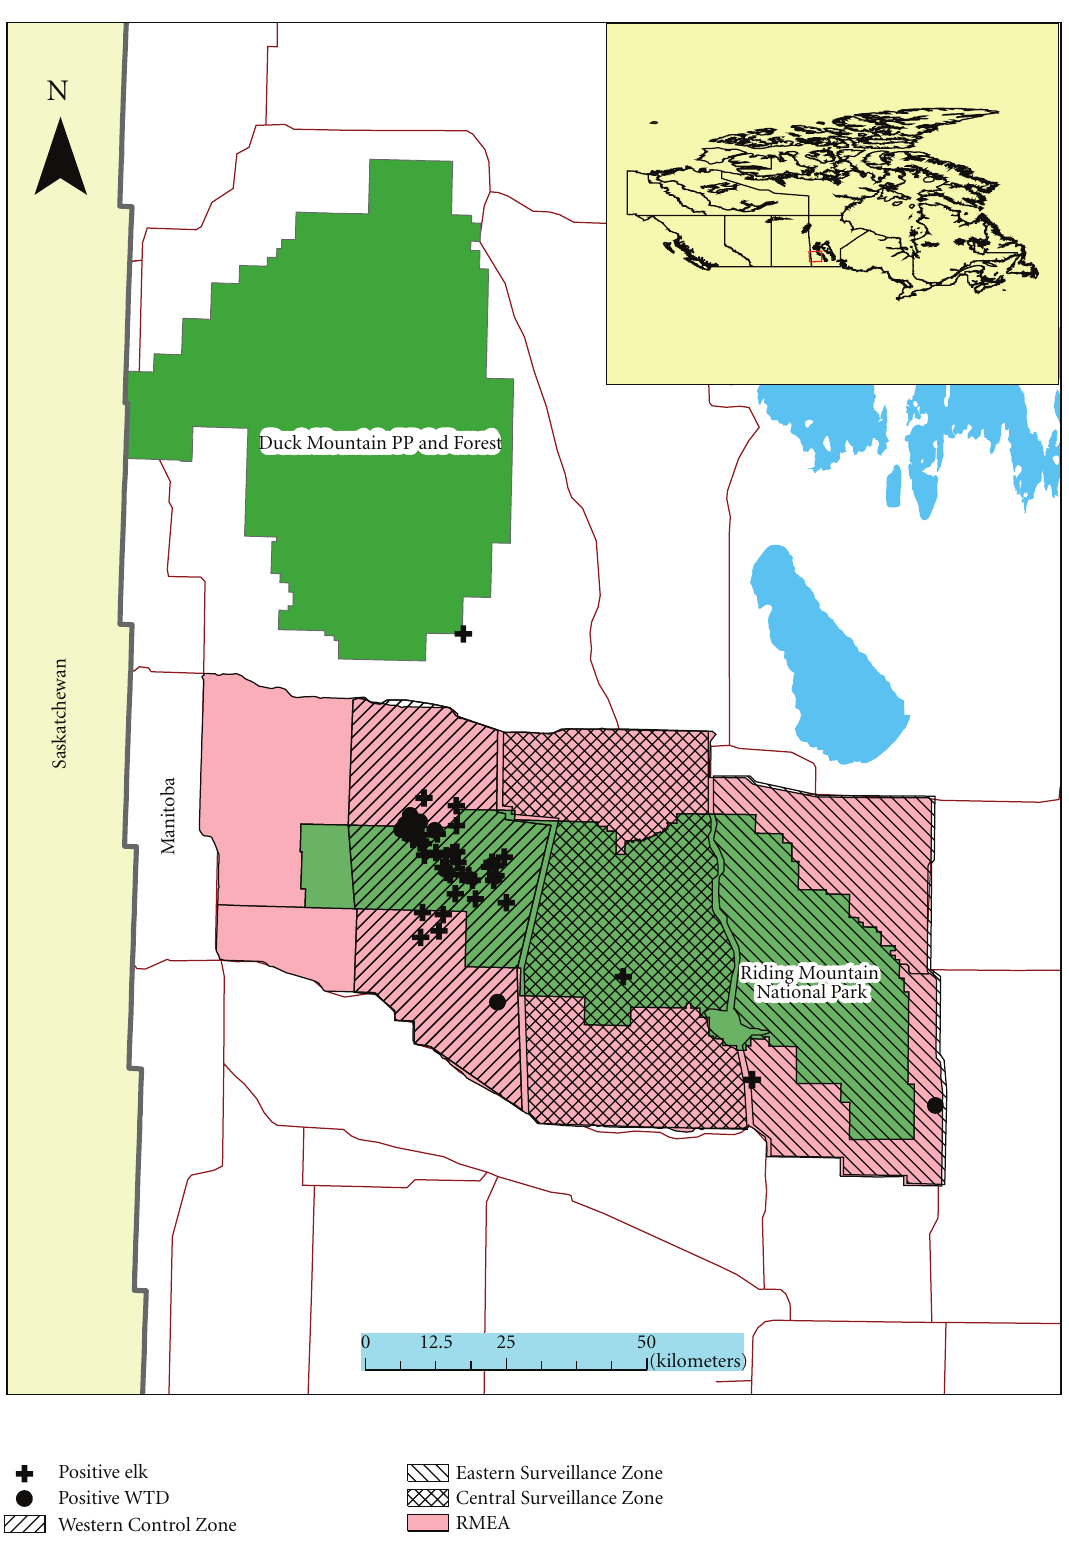
Figure 1: Locations of sampling zones and M. bovis culture positive elk and deer cases in south-western Manitoba from 1997 to